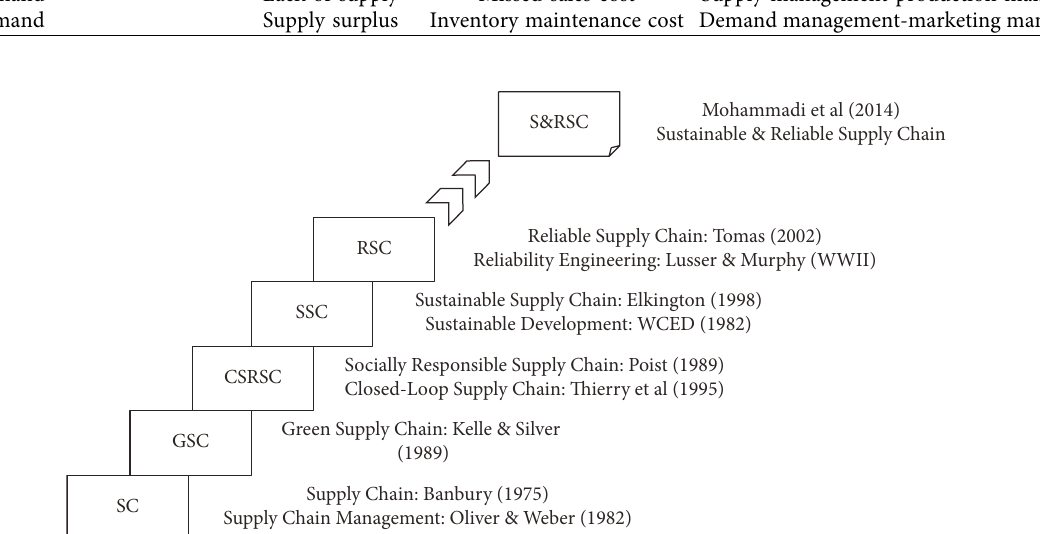
Figure 4: History of the emergence of an S&RSC management paradigm.